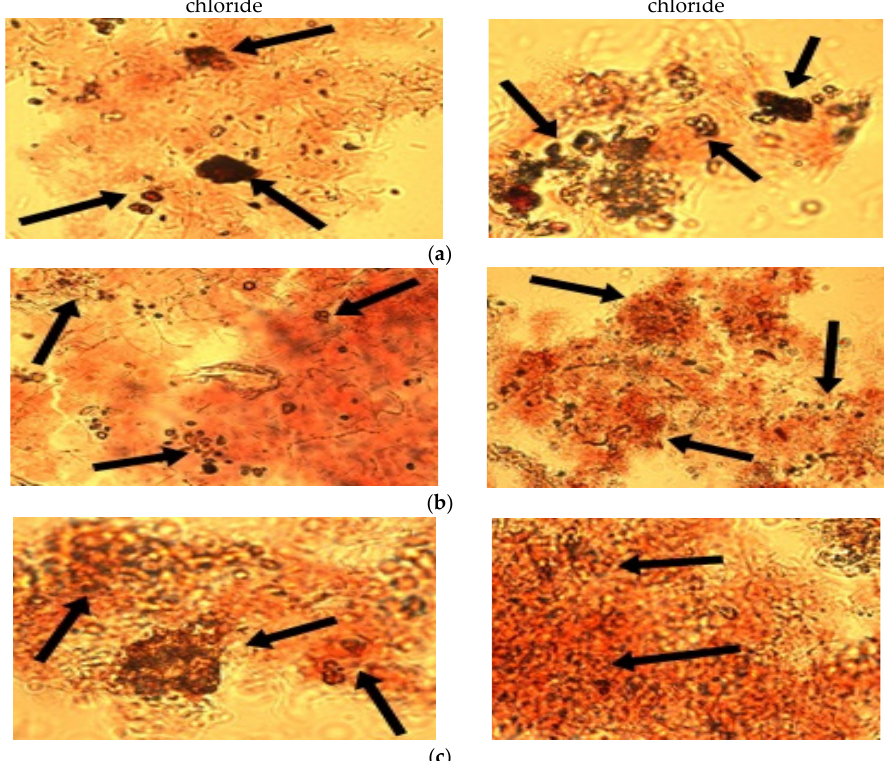
Figure 2. Optical microscopy applied to bacterial culture broth after coloring with red alizarin S (×40): ( a ) Bacillus amyloliquefaciens; ( b ) Bacillus subtilis; ( c ) Bacillus licheniformis. Black arrow—calcium carbonate crystals.